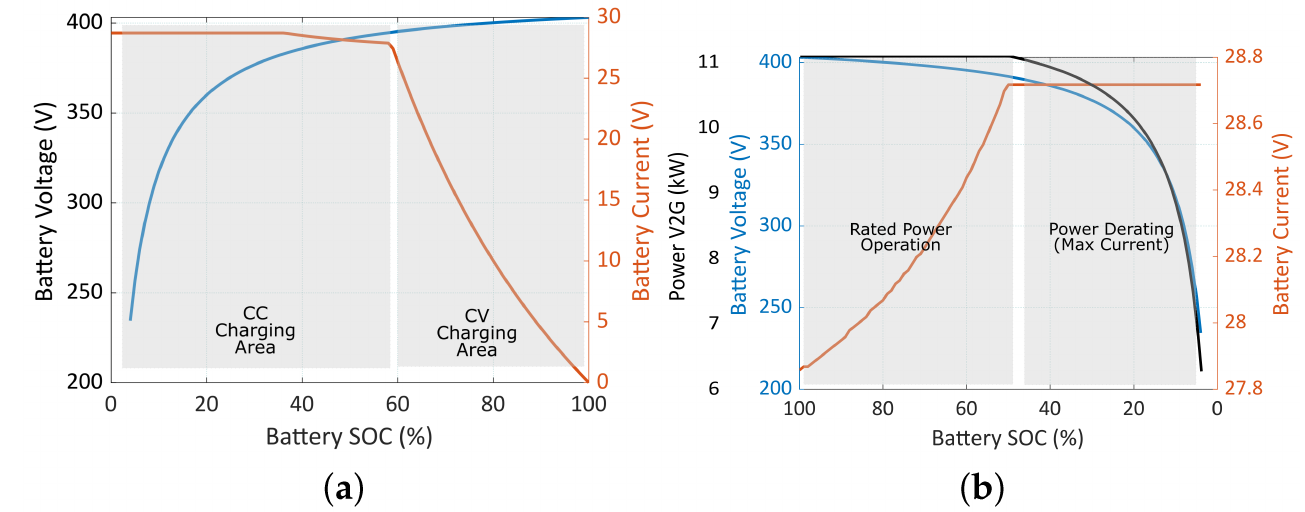
Figure 2. Typical battery current and voltage waveforms for ( a ) G2V, ( b )